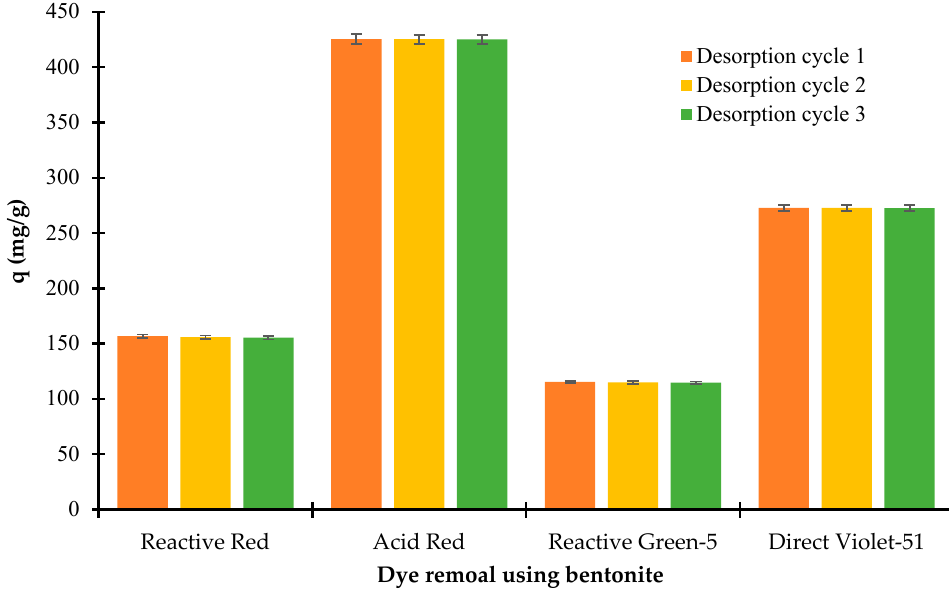
Figure 10. Adsorption capacity (mg/g) of adsorbent after desorption cycle.